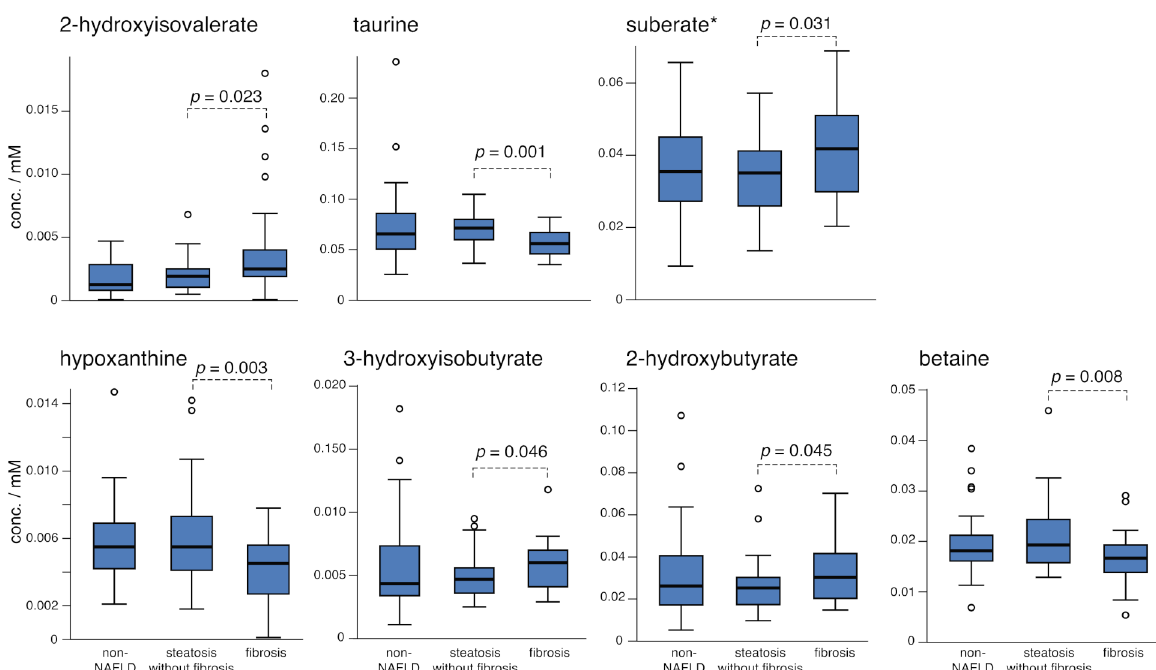
Figure 2. Boxplots of metabolite concentrations for which means changed significantly in this study between the steatosis and fibrosis groups (the non-NAFLD liver group is included for comparison). * Suberate profiling is confounded with another medium chain fatty acid pimelate (see additional medium chain fatty acids in Figure S3). See also Figure S4, where a weak accumulation of propylene glycol is suggested ( p = 0.050). Multiply concentrations by 2 for the serum